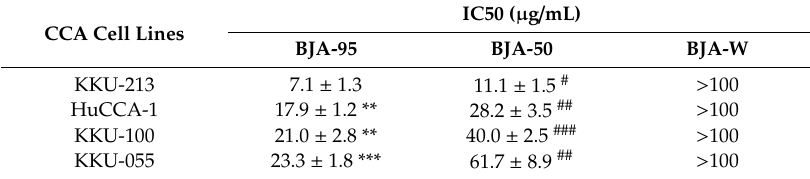
Figure 1. Cytotoxic e ff ect of Benja Amarit (BJA) against cholangiocarcinoma (CCA) cell lines. Human cholangiocarcinoma ( A ) KKU-213, ( B ) KKU-100, ( C ) KKU-055 and ( D ) HuCCA-1 cells were treated with 0–100 µ g / mL of BJA-95, BJA-50 and BJA-W for 24 h. Cell viability was then measured using an MTT assay. Results are shown as mean ± SD values from three repeated independent experiments. (*) p < 0.05, (**) p < 0.01, (***) p < 0.001 and (****) p < 0.0001 when compared with the control (without treatment). Table 1. The half maximal inhibitory concentration (IC50) of BJA on CCA cell lines.